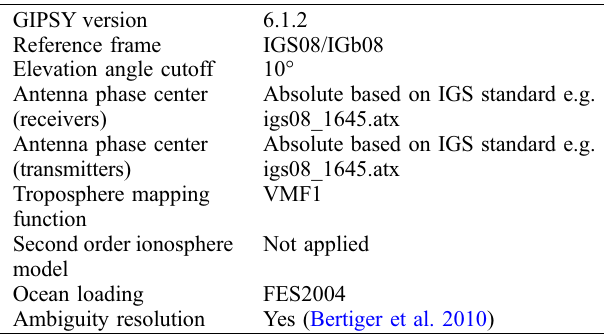
Table 2. Parameters/models used for the GIPSY PPP